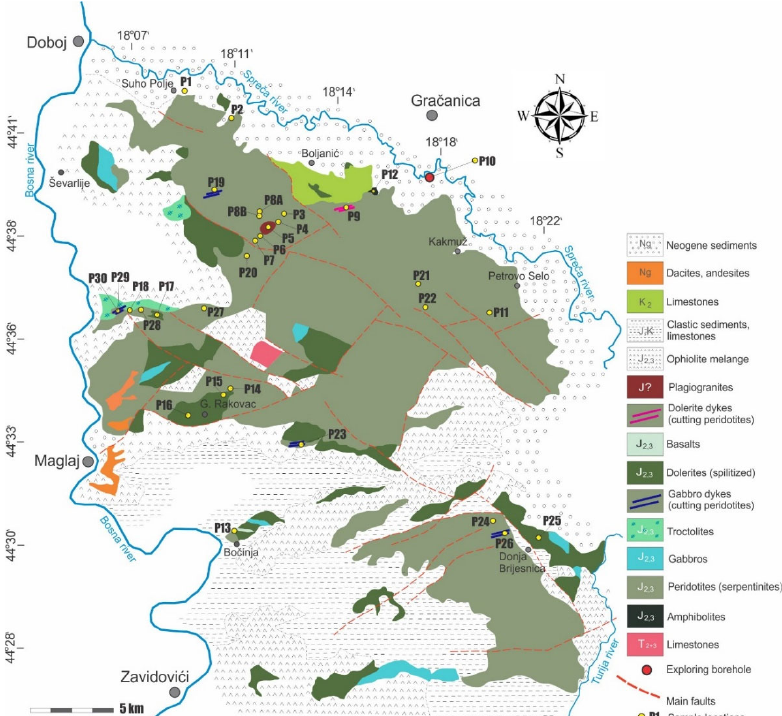
Figure 2. Ozren ophiolitic complex. Geological map compiled from [33], two geological sheets (Zavidovi´ci, Doboj) of the basic geological map of the former SFR Yugoslavia 1:100,000 [45,46], and new data from our investigation with sample numbers.